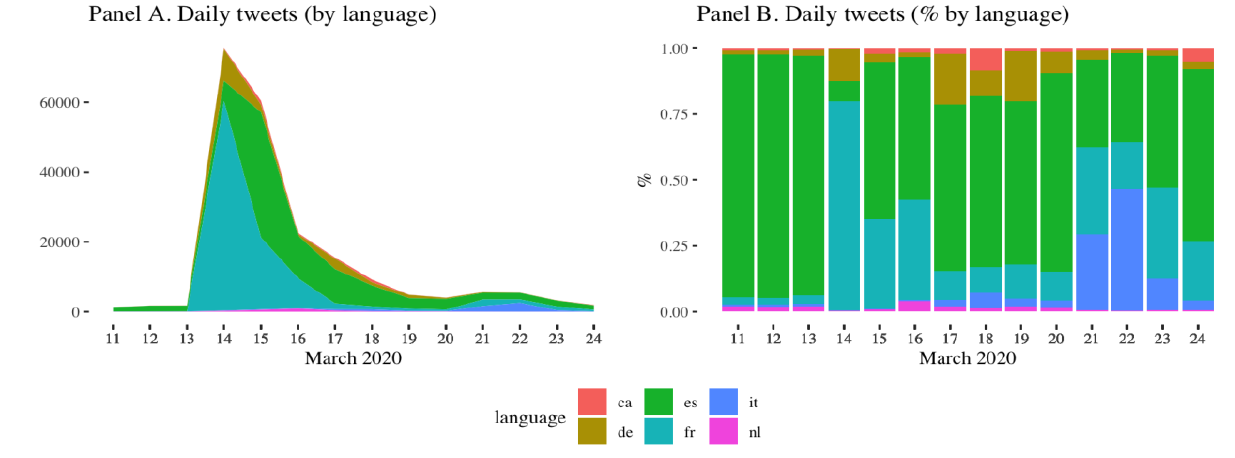
Figure 2. Tweets per language: Absolute (Panel A). Percentual (Panel